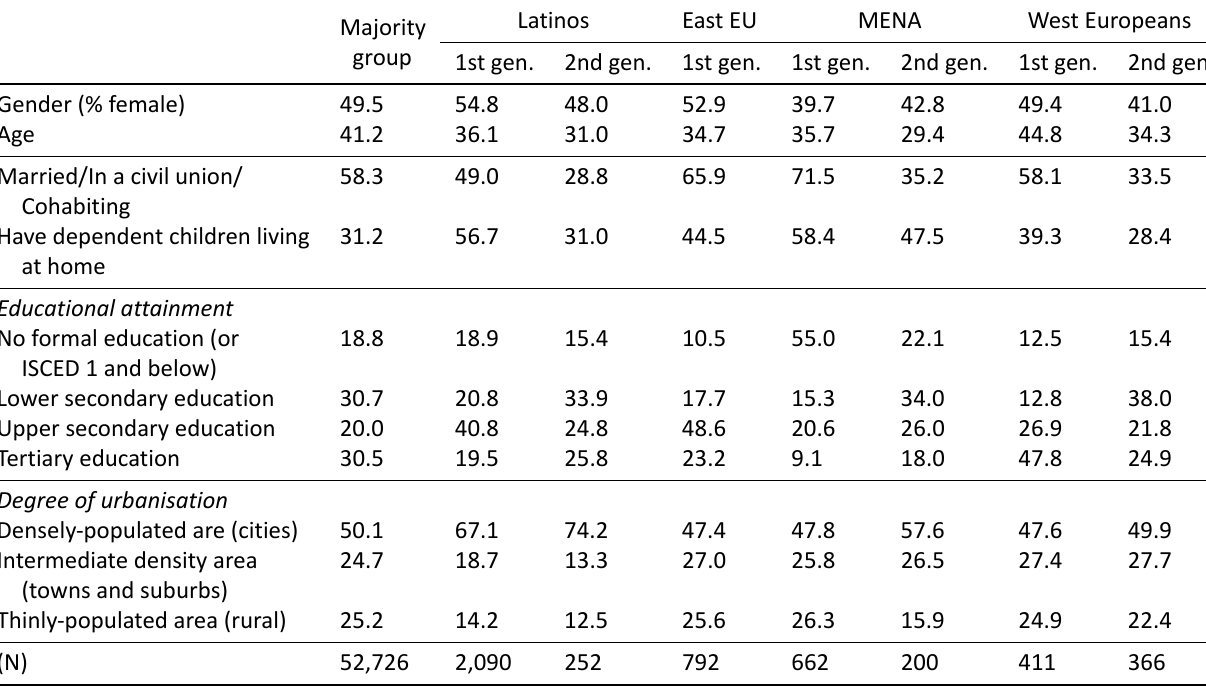
Table 1. Sociodemographic and control variables by gender, ethnicity and generation (%) in 2008.